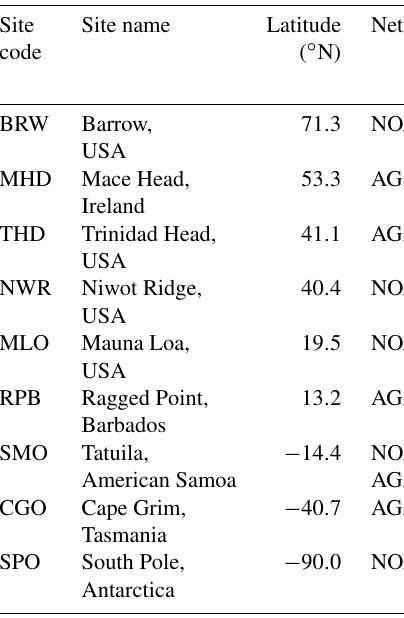
Table 3. For each ground station the table columns show respectively: site code, site name, site latitude, network name, station-related CCl 4 trend, tropospheric MIPAS trend, and latitudinal band from which MIPAS data were